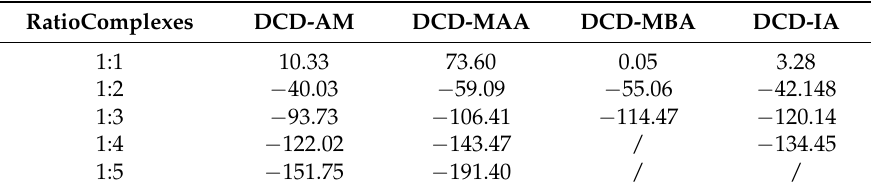
Table 2. Binding energies ( ∆ E B1 , kJ/mol) of DCD and different functional monomers in different ratios at the M062X/6-31G(d,p)